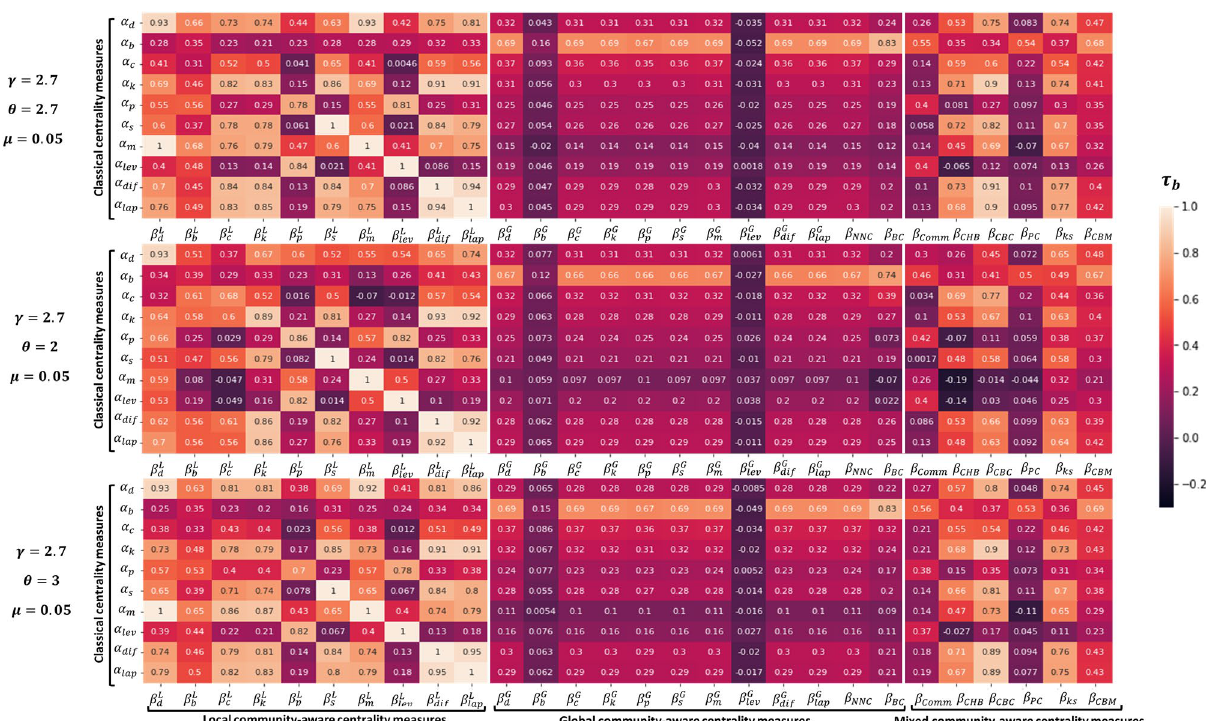
Figure 5. Heatmaps of Kendall’s Tau correlation of the various combinations between classical ( α i ) and community-aware ( β j ) centrality measures in synthetic networks. γ is the exponent of the degree distribution. θ is the exponent of the community size distribution. Three values are used [2, 2.7, 3]. µ is the mixing parameter. The classical centrality measures are: α d = Degree, α b = Betweenness, α c = Closeness, α k = Katz, α p = PageRank, α s = Subgraph, α m = Maximum Neighborhood Component, α lev = Leverage, α dif = Diffusion, α lap = Laplacian. The local community-aware centrality measures are: ( β L d , β L b , β L c , β L k , β L p , β L s , β L m , β L lev , β L dif , β L lap ) = the local component of the classical centrality measures based on modular centrality. The global community-aware centrality measures are: ( β G d , β G b , β G c , β G k , β G p , β G s , β G m , β G lev , β G dif , β G lap ) = the global component of the classical centrality measures based on modular centrality, β NNC = Number of Neighboring Communities centrality, β BC = Bridging centrality. The mixed community-aware centrality measures are: β Comm = Comm centrality, β CHB = Community Hub-Bridge centrality, β CBC = Community-based centrality, β PC = Participation Coefficient, β ks = K-shell with Community centrality, β CBM = Community-based Mediator